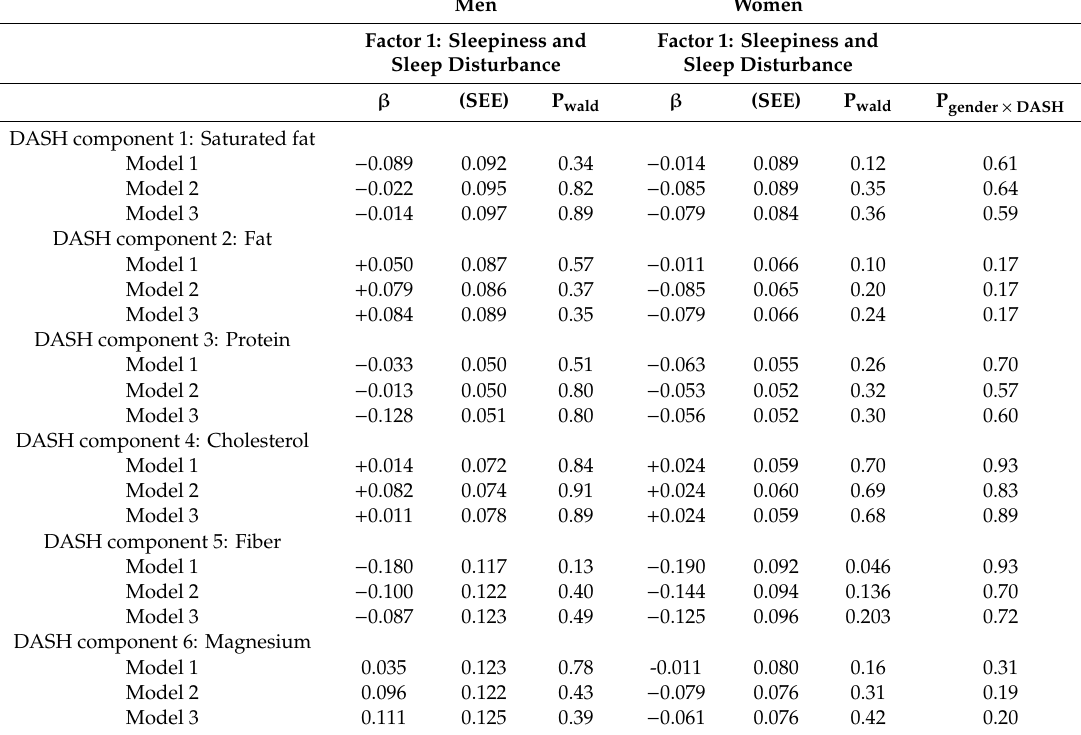
Table 3. DASH component scores as predictors of sleep quality measures, stratified by gender multiple linear regression models, the NHANES